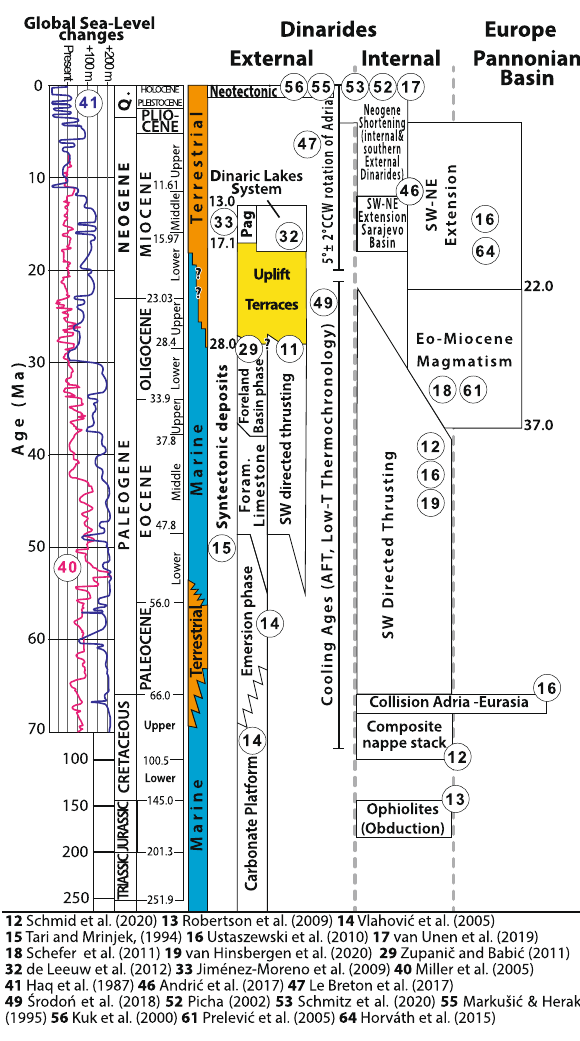
The time span of the formation and uplift of the marine terraces is marked in